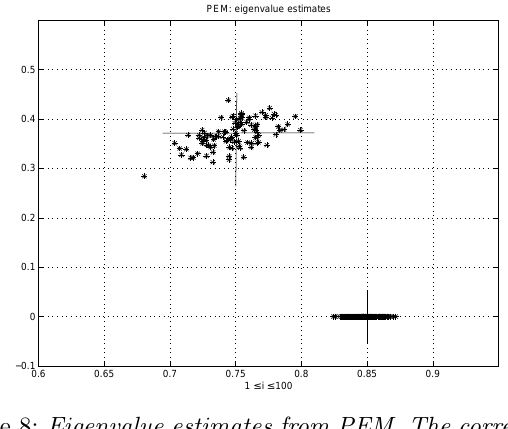
Figure 8: Eigenvalue estimates from PEM. The correct eigenvalues are λ 1 = 0 . 85 and a complex con- jugate pair, λ 2 , 3 = 0 . 75 ± j 0 . 3708 . Complex eigenvalues are in complex conjugate